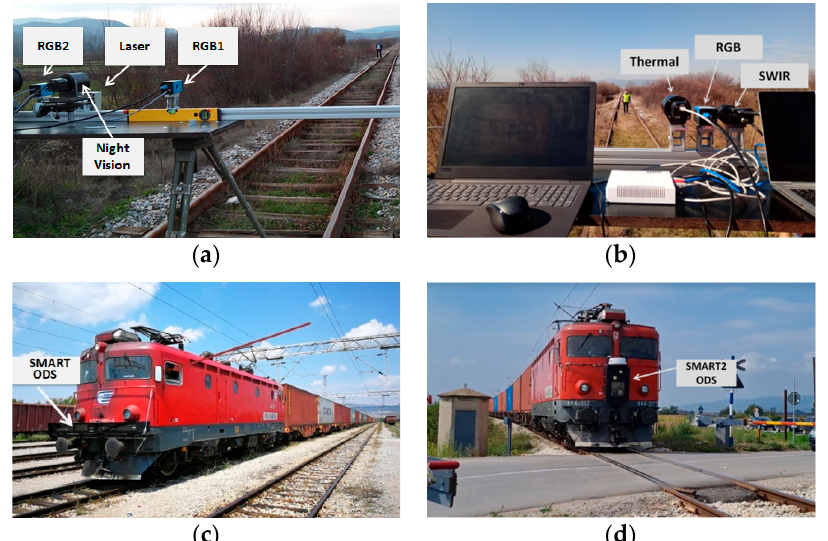
Figure 1. SMART and SMART2 field tests for dataset generation: Test-stand with the SMART ( a ) and SMART2 ( b ) sensors viewing the rail tracks and an object (human) on the rail tracks; SMART ( c ) and SMART2 ( d ) vision sensors for obstacle detection integrated into sensors’ housing mounted on the frontal profile of a locomotive.